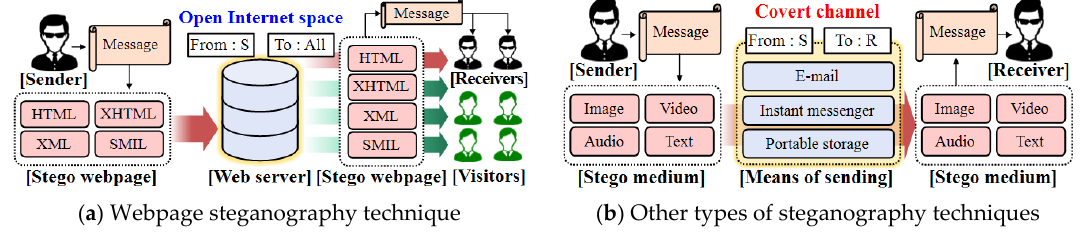
Figure 1. Webpage steganography technique vs. other types of steganography techniques.